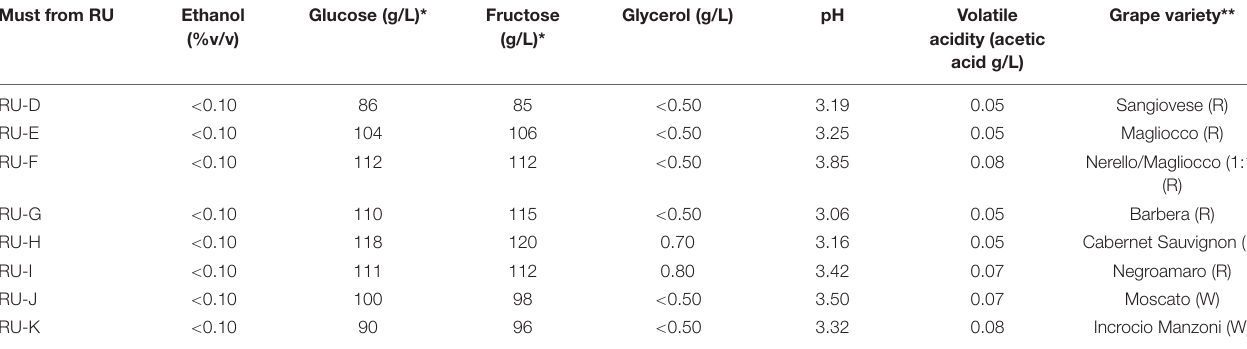
TABLE 2 | Main enological parameters of grape musts used from the research units